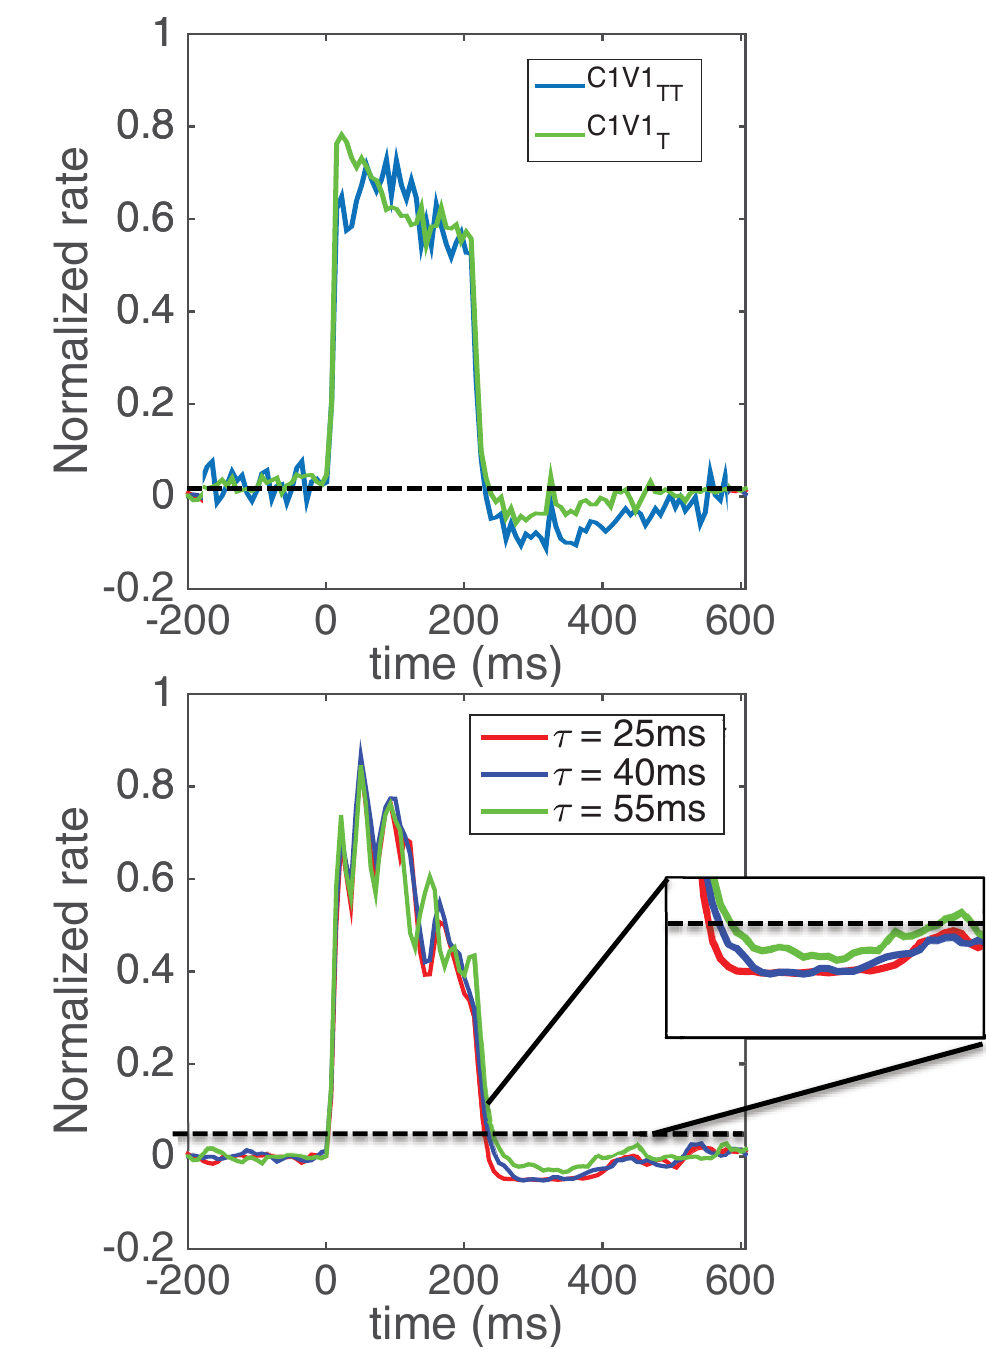
Fig 7. Experimental data from macaque primary visual cortex matches model prediction. By analyzing the C1V1 TT (t off = 45 ms) and C1V1 T (t off = 60 ms) temporal response profiles obtained from macaque V1, we see that the C1V1 TT opsin shows higher magnitude (top) of suppression following laser offset. This is consistent with the model prediction (bottom). stimulated excitatory neurons, which has been shown experimentally [15]. Somatostatin neu- rons have been shown to act on GABA-B receptors and suppress dendritic activity [16–18]